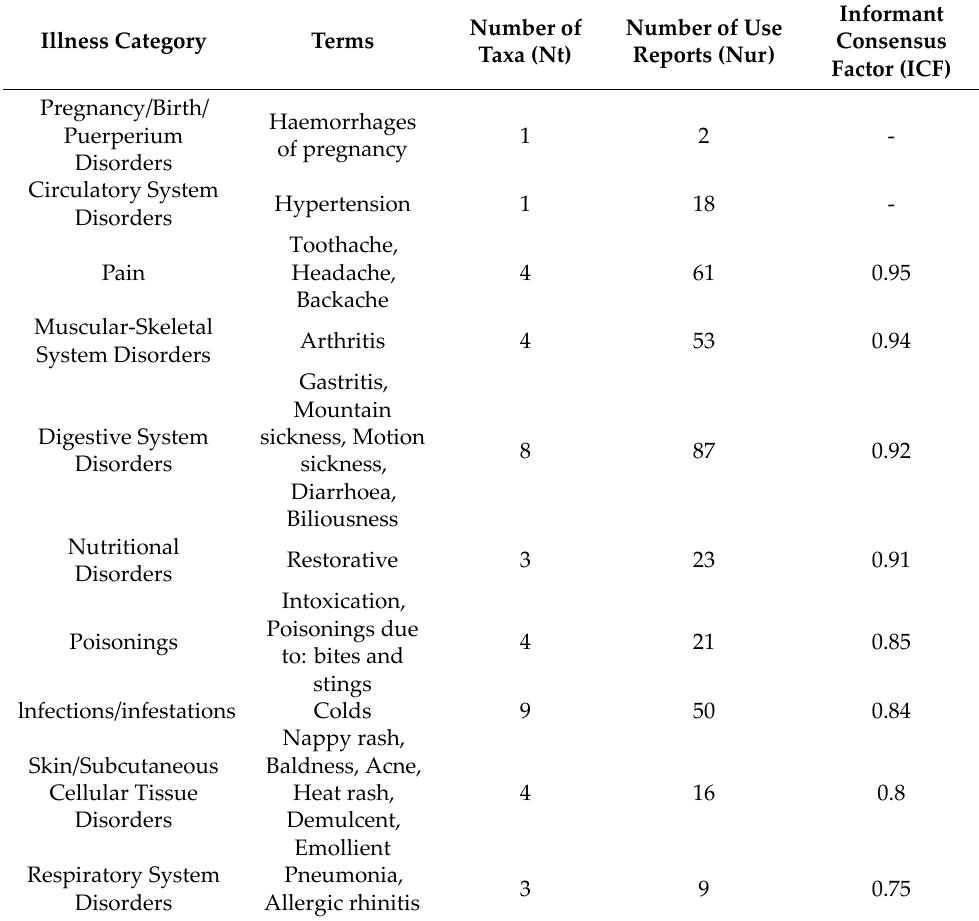
Table 3. Informant consensus factor for traditional medicinal plant use